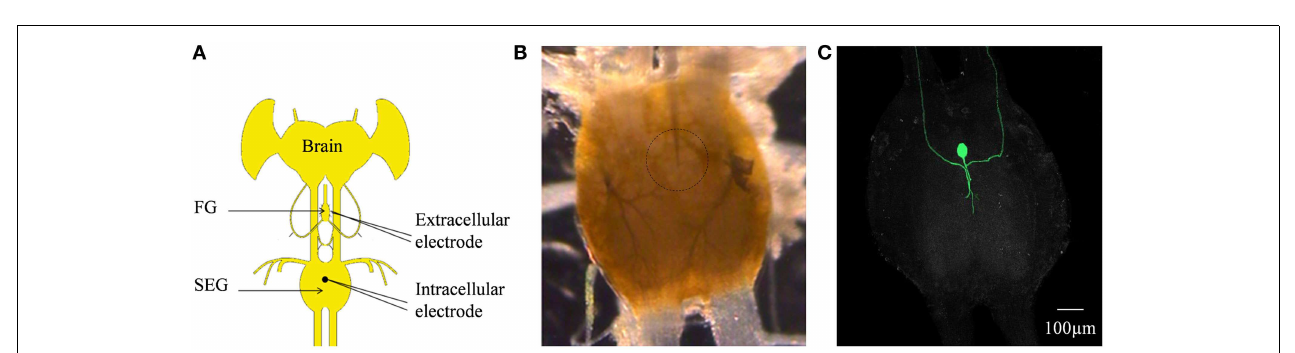
FIGURE 6 | Simultaneous extracellular recordings from the FG and HG in an in vitro FG + HG preparation, showing the effect of 10 − 4 M OA on the FG and HG rhythmic activity. The outlined frame in the left panel is shown to the right on an extended time scale.The rectified and smoothed signals (red) are aligned on top of the unprocessed signals. OA application resulted in decreased frequency of the synchronized